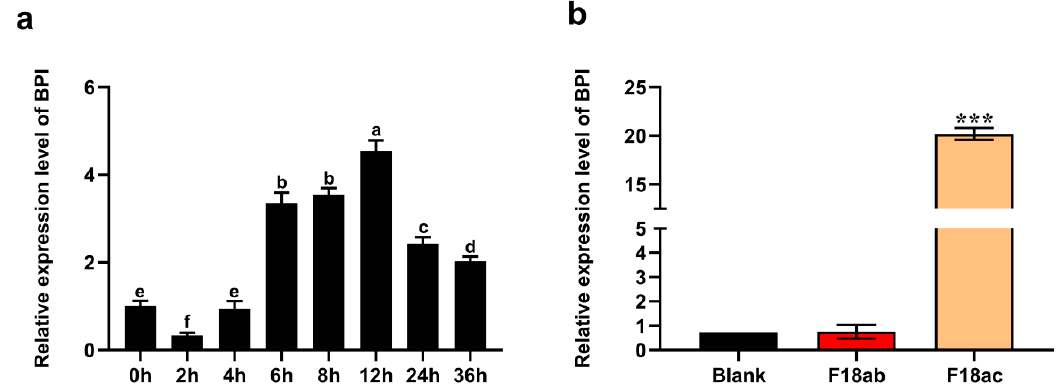
Figure 1. The impact of LPS and E. coli F18 stimulation on BPI gene expression. ( a ) LPS was used to stimulate porcine kidney (PK15) cells for 0, 2, 4, 6, 8, 12, 24 and 36 h, after which bactericidal / permeability-increasing protein ( BPI ) expression was analyzed. Di ff erent lowercase letters indicate significant di ff erences ( p < 0.05), whereas identical letters indicate a lack of any di ff erence between groups ( p > 0.05). ( b ) BPI expression was assessed in PK15 cells following stimulation with E. coli F18ab or F18ac. Blank: untreated control group. Samples were analyzed in triplicate. Data are means ± standard deviation. *** p < 0.001.